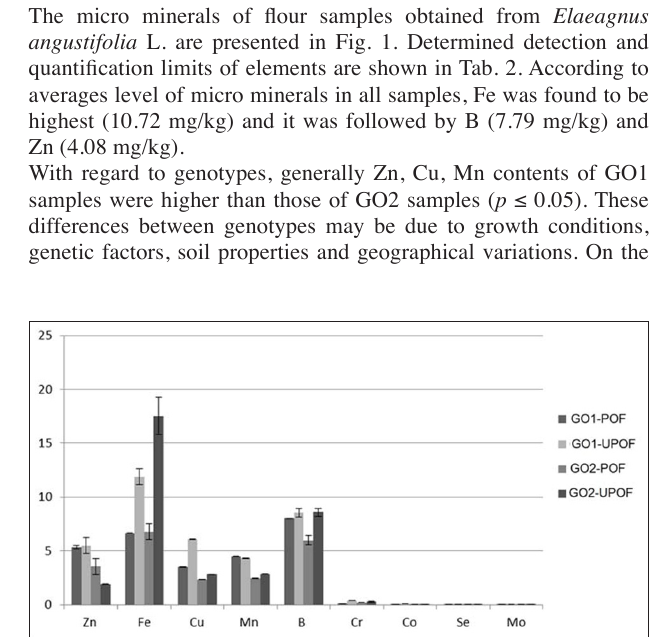
Fig. 1: The micro minerals of peeled (POF) and unpeeled (UPOF) oleaster flours from two genotypes (GO1 and GO2). Data show mean values of three replicates +/- standard error.